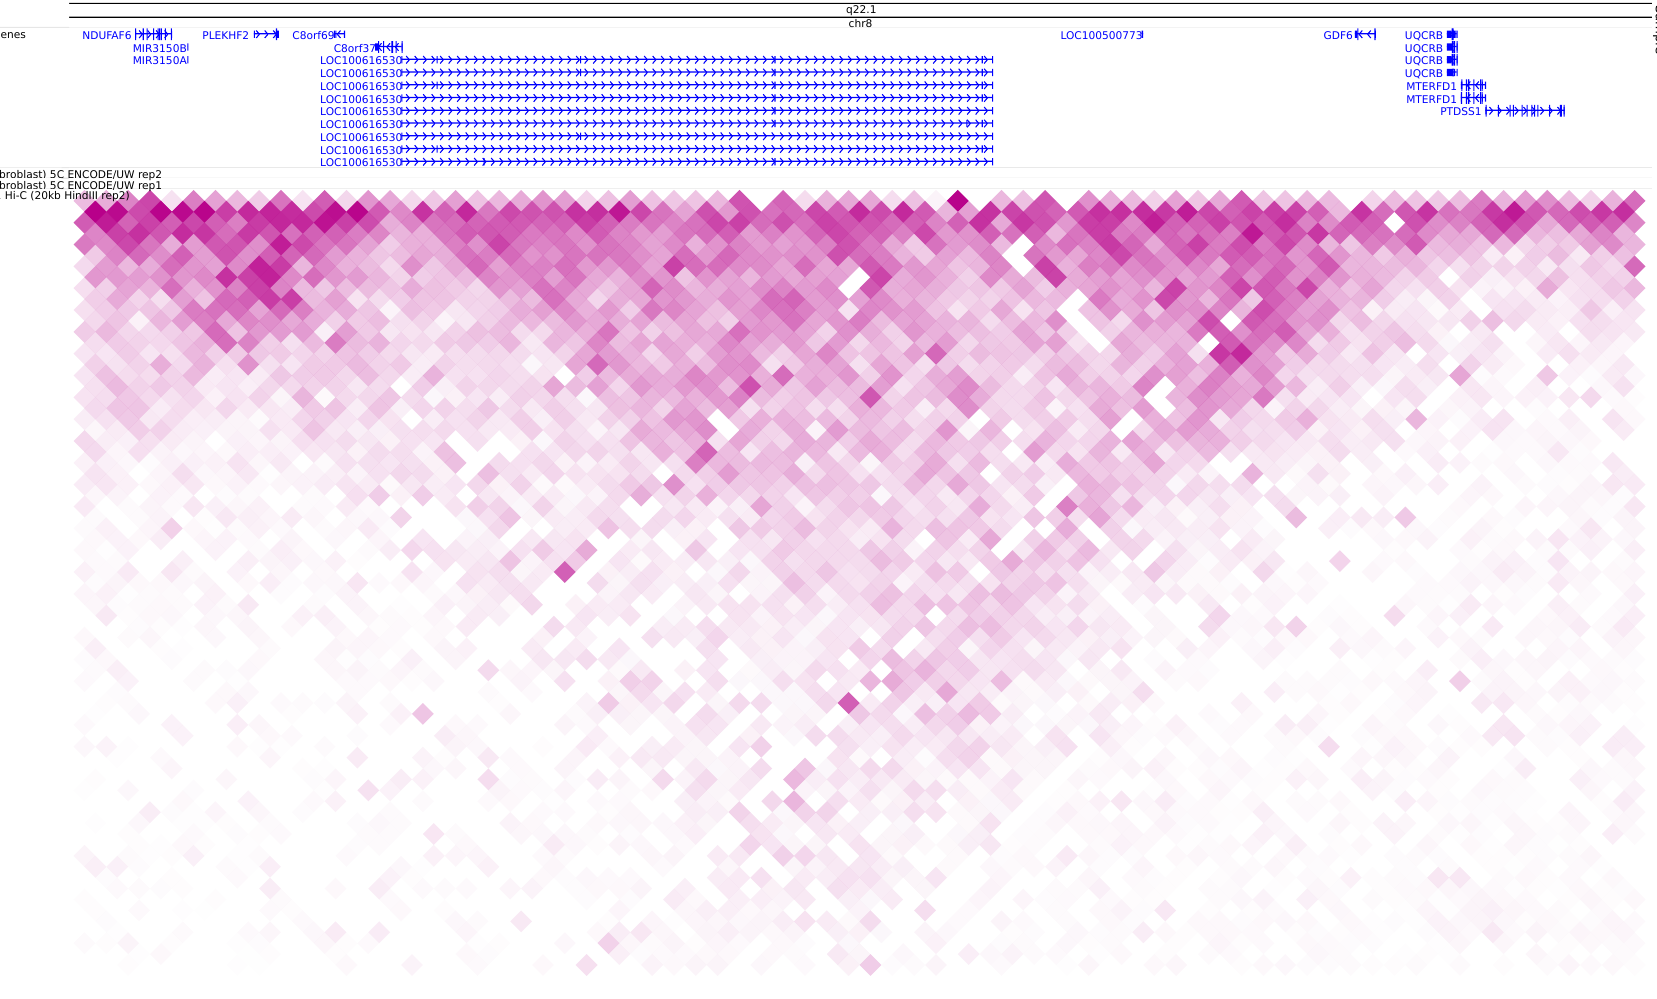
Figure 8. Genome-wide 4C and Hi-C interaction across the SMALLTALK/TOSEPAK/GDF6 locus provided by the Encode & NIH Roadmap projects available at http://promoter.bx.psu. edu/hi-c/view.php (accessed on 10 August